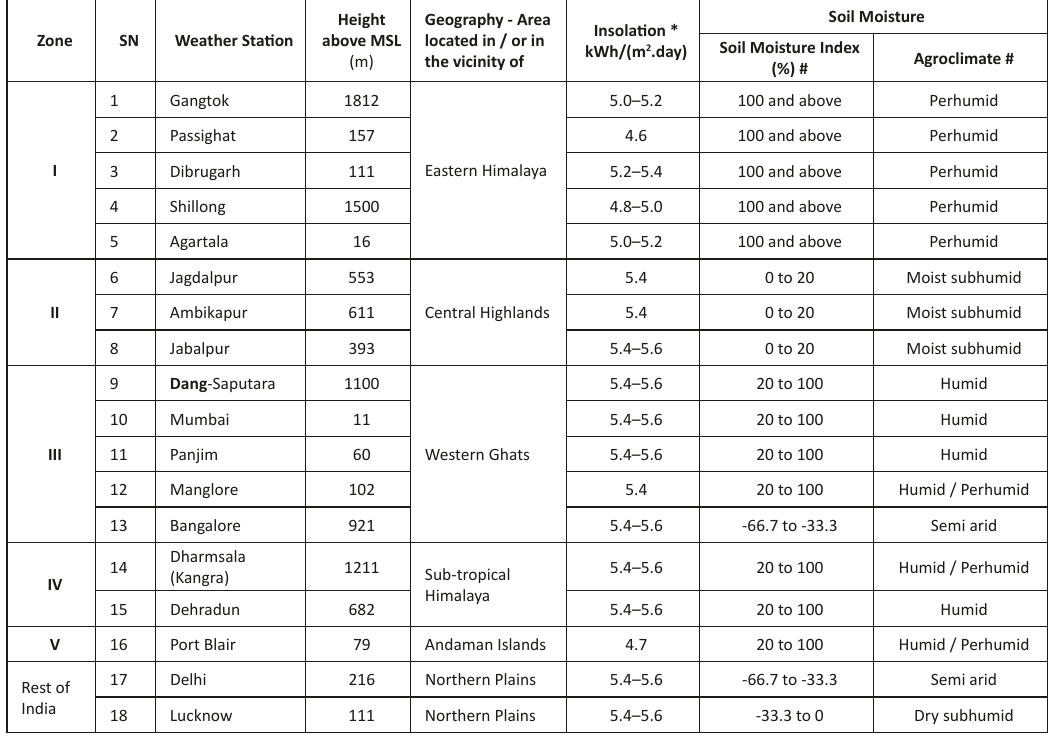
Table 2. Euthalia aconthea butterfly habitat - topography, insolation and soil